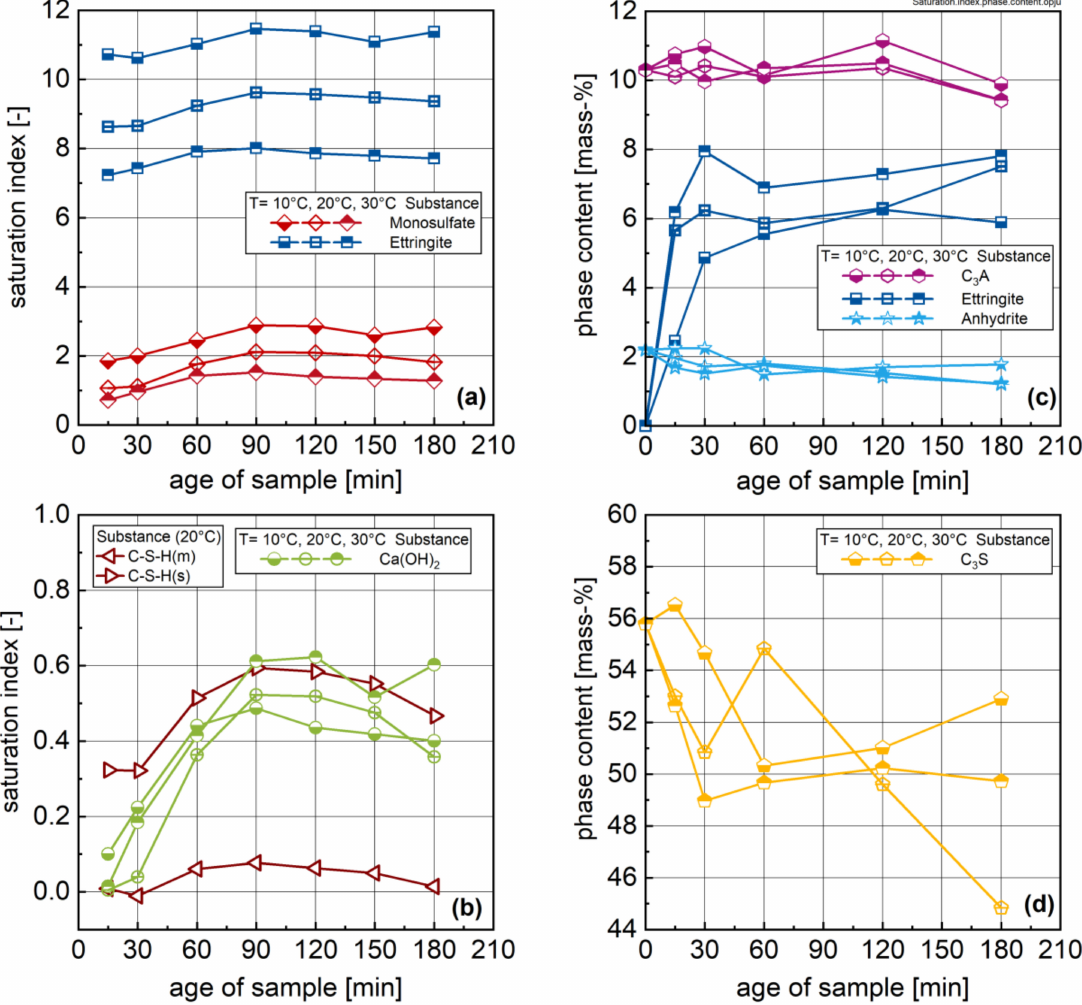
Figure 6. Saturation indices for ettringite and AFm ( a ), Ca(OH) 2 , metastable C–S–H(m) and stable C–S–H(s) ( b ); content of ettringite, C 3 A and anhydrite ( c ); and C 3 S (by QXRD) during the first 3 h of hydration ( d